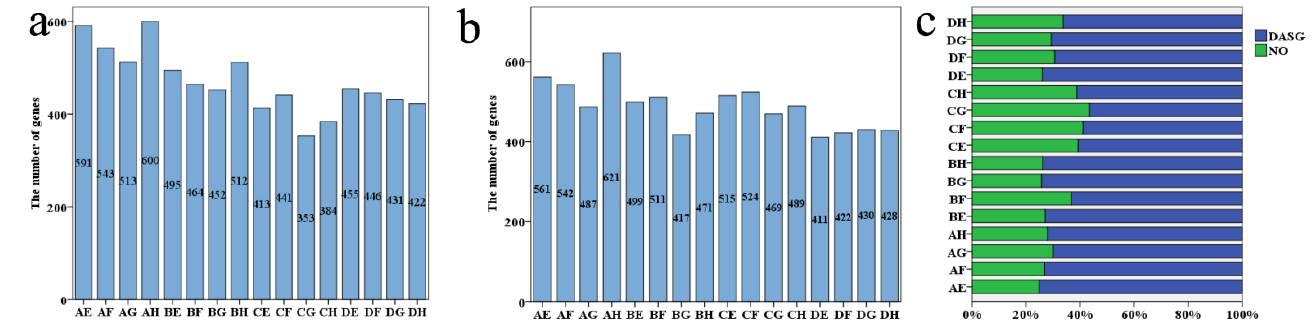
Figure 5. Different AS events. ( a ) Different AS events between parents. ( b ) Different AS events between parents and hybrid. ( c ) Percentage of different AS genes between parents in different AS genes between hybrid and parents.